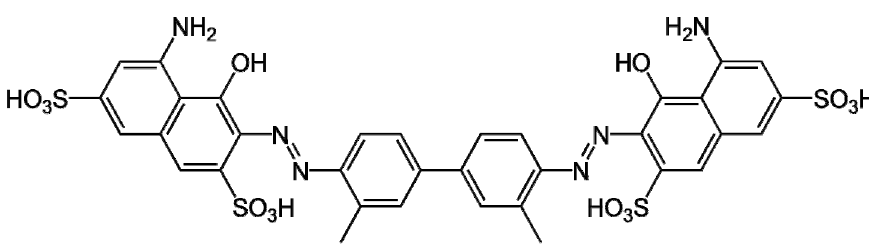
Figure 4. Molecular structure of trypan